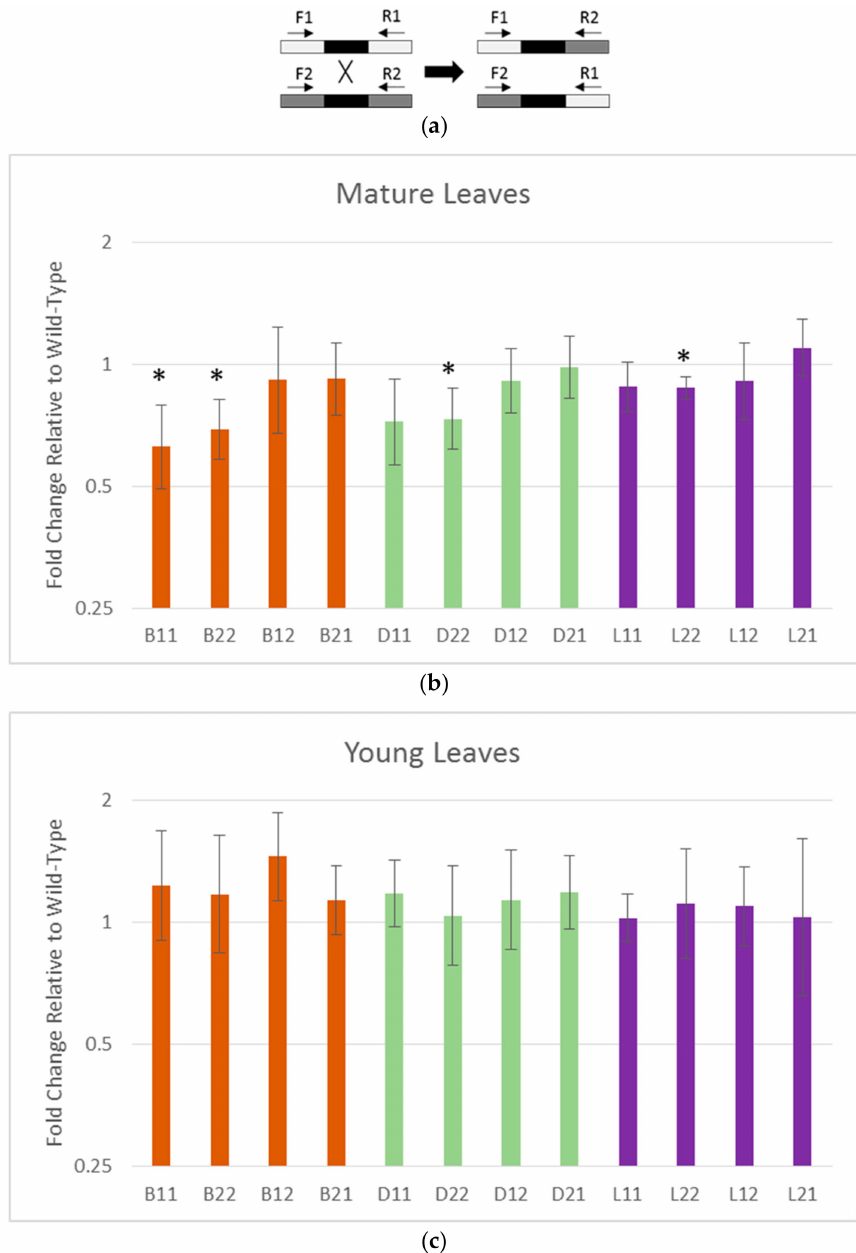
Figure 2. qPCR analysis of intermediate repeat recombination in UNG lines compared to wild-type: Recombination at intermediate repeats is an indicator of increased double-strand breaks in plant mitochondrial genomes. ( a ) Primer scheme for detecting parental and recombinant repeats: Using di ff erent combinations of primers that anneal to the unique sequence flanking the repeats, either parental type (1 / 1 and 2 / 2) or recombinant type (1 / 2 and 2 / 1) repeats can be amplified. ( b ) Fold change of intermediate repeats in young leaves of UNG lines relative to wild-type: Error bars are standard deviation of three biological replicates. ( c ) Fold change of intermediate repeats in mature leaves of UNG lines relative to wild-type: Error bars are standard deviation of three biological replicates. B1 / 1, B2 / 2, D2 / 2, and L2 / 2 show significant reduction in copy number (unpaired, 2-tailed student’s t-test, * indicates p <